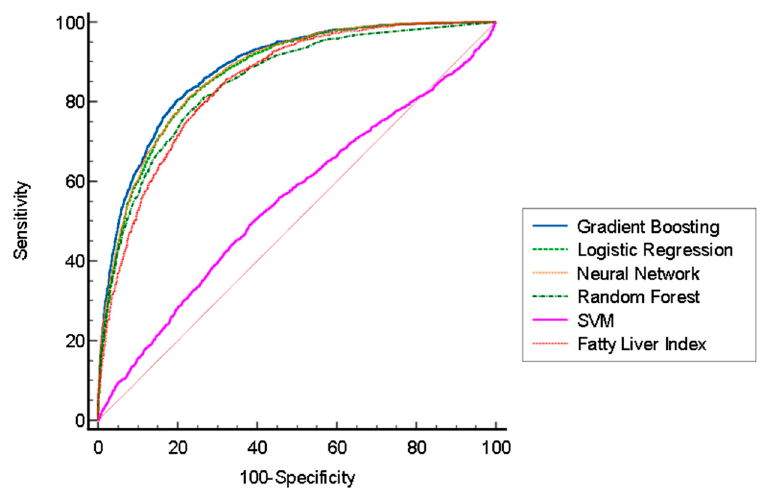
Figure 2. AOC curve of five different machine-learning models and the fatty liver index.